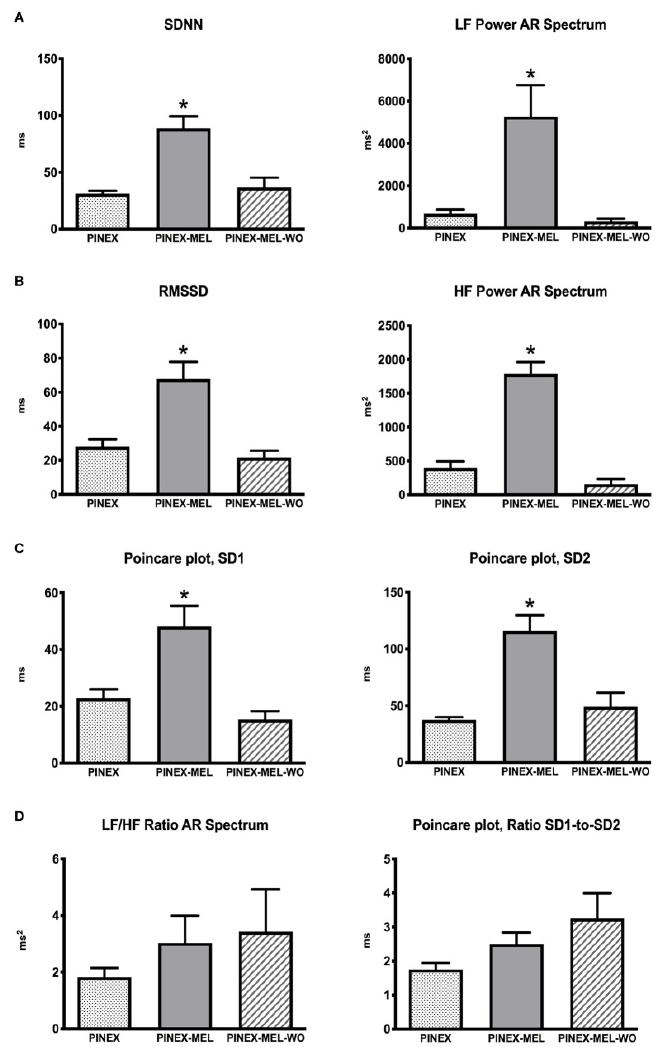
Figure 6. ( A ) Sympathetic modulation of heart rate variability (HRV) +/ − the standard deviation of the normal R-R wave interval (SDNN). ( B ) Parasympathetic modulation measures: root mean square of the successive R-R interval differences (RMSSD). ( C ) Parasympathetic modulation: Poincar é plot analysis measures of SD1 and SD2; * p < 0.05 significantly different from the other groups. ( D ) Autonomic balance estimated through the ratio of SD1 to SD2 of Poincar é plot and LF/HF ratio of AR spectrum. From Campos et al.